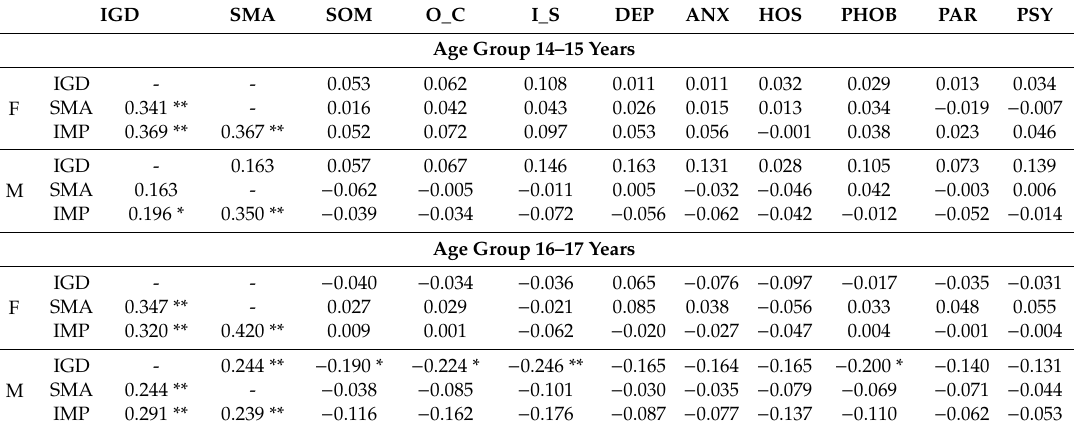
Table 4. Bivariate correlations between the variables of interest for gender per age